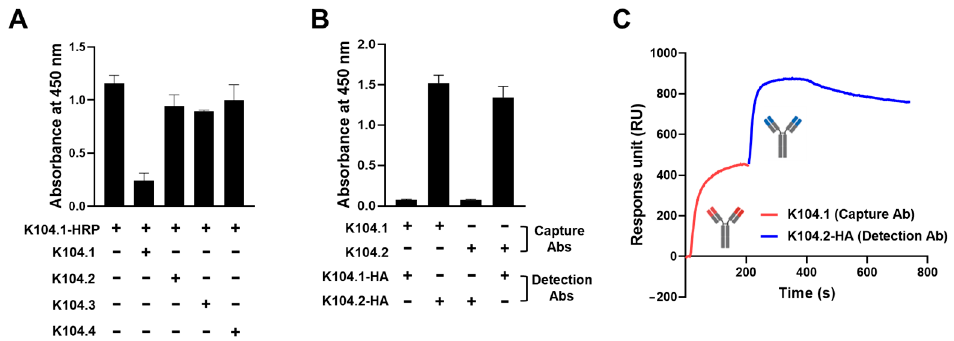
Figure 3. Identification of a suitable SARS-CoV-2 spike protein-specific antibody pair for sandwich immunoassay. ( A ) Competition ELISA to identify mAbs that do not compete with K104.1 for binding to SARS-CoV-2 S-ECD. Results are represented as mean ± SD of duplicates and represent one out of two independent experiments. ( B ) Sandwich immunoassay conducted using the untagged forms of K104.1 or K104.2 as capture antibodies and anti-hemagglutinin (HA)-tagged K104.1 (K104.1-HA) and K104.2 (K104.2-HA) as detection antibodies. Results are represented as mean ± standard deviation (SD) of duplicates from one out of two independent experiments. ( C ) Additional binding of K104.2-HA (blue) to SARS-CoV-2 S-ECD saturated with K104.1 (red) was analyzed using SPR measurements. This is a representative curve of two independent experiments.